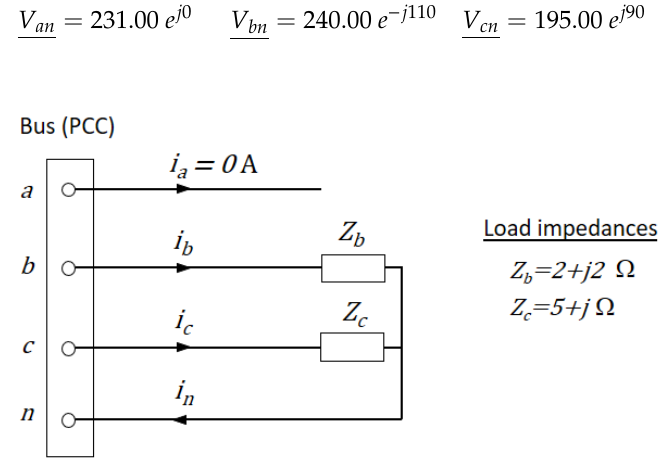
Figure 7. Unified proposal with compensator “SVC + NSCC” connected in delta. SVC = positive- sequence reactive component; NSCC = negative-sequence currents.